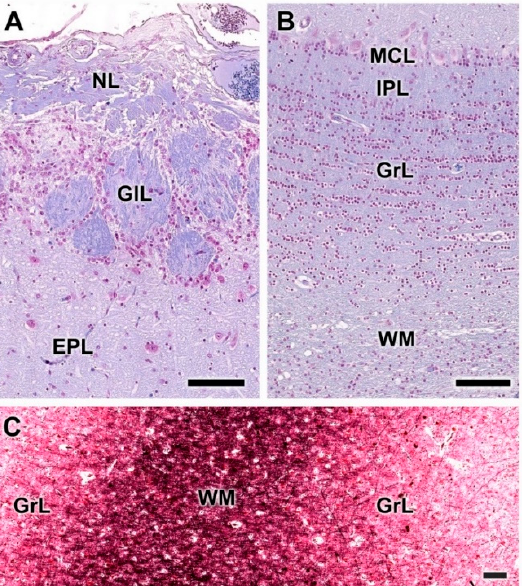
Figure 21. Histological study of the olfactory bulb of the fox stained with Gallego’s trichrome. ( A , B ) Superficial and deep layers, respectively. The glomeruli are wholly surrounded by periglomerular cells. The granular layer (GrL) is formed by aligned clusters of granule cells. ( C ) Tolivia staining shows a high density of myelinic fibers in white matter (WM). Scale bars: 100 µm.